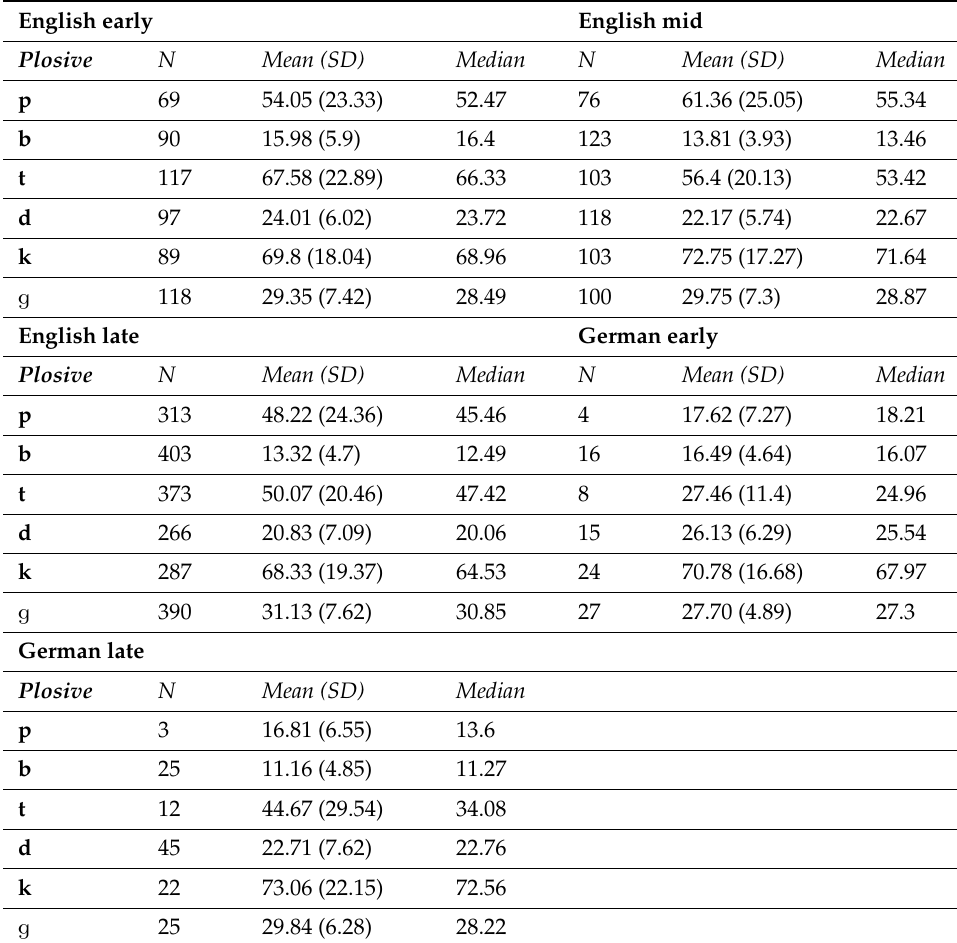
Table A1. Means, standard deviations and medians for AS’s VOT durations (reported in milliseconds) obtained for his English and German plosives across different stages in time, including the number of tokens ( N ) measured for each plosive according to language and stage.